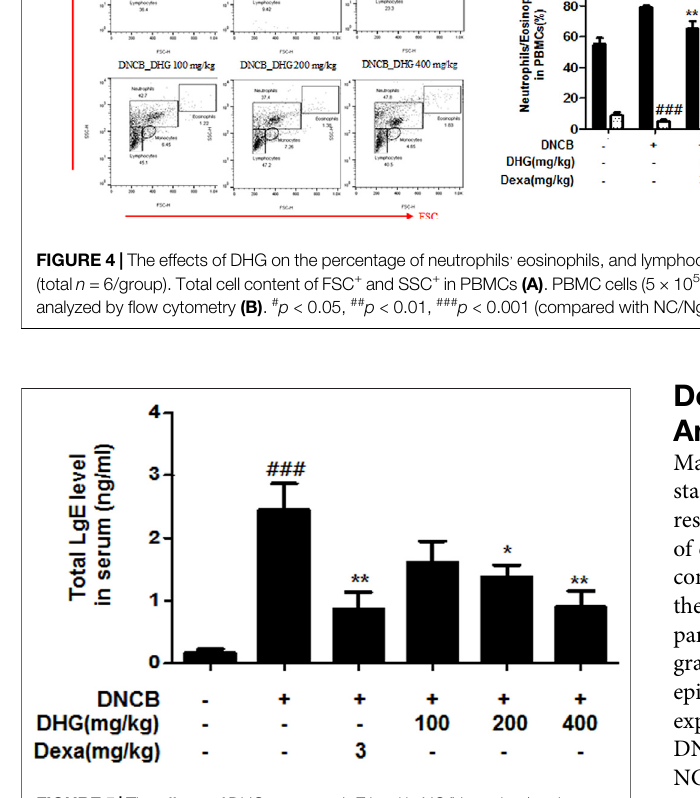
FIGURE 5| The effectsof DHG on serum IgE level in NC/Nga mice (total n = 6/group). Total IgE levels were measured by asandwich ELISA. # p < 0.05, ## p < 0.01, ### p < 0.001 (compared with NC/Nga-Nr). * p < 0.05, ** p < 0.01, and *** p < 0.001 (compared with